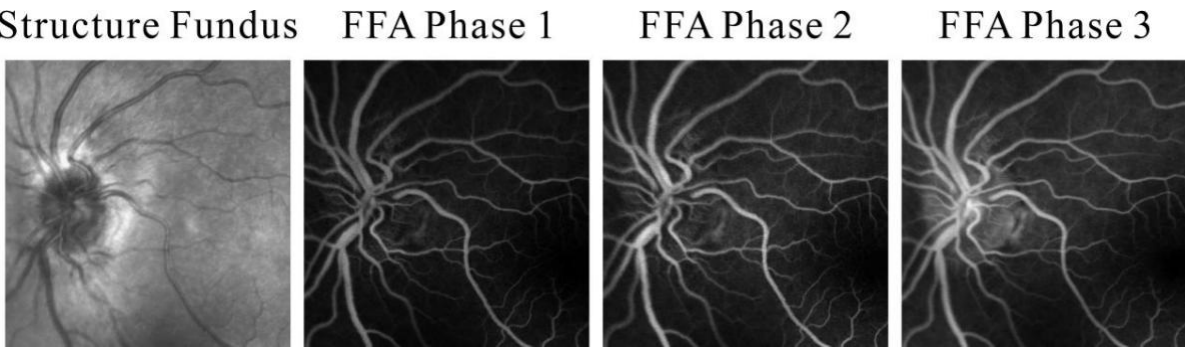
Figure 2. Example of the manually registered images group containing the fundus structure image and the corresponding three ‐ phase FFA images.